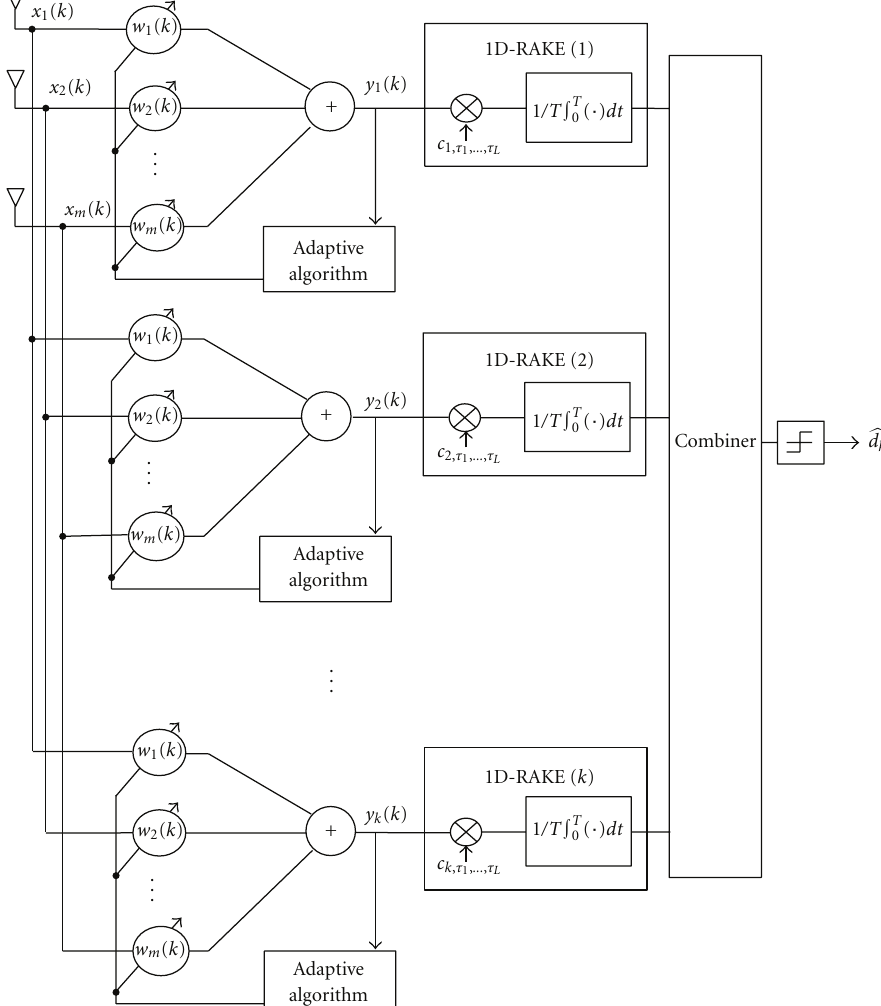
Figure 3: WCDMA system using a combination of 2D-RAKE receiver and CCM-RLS